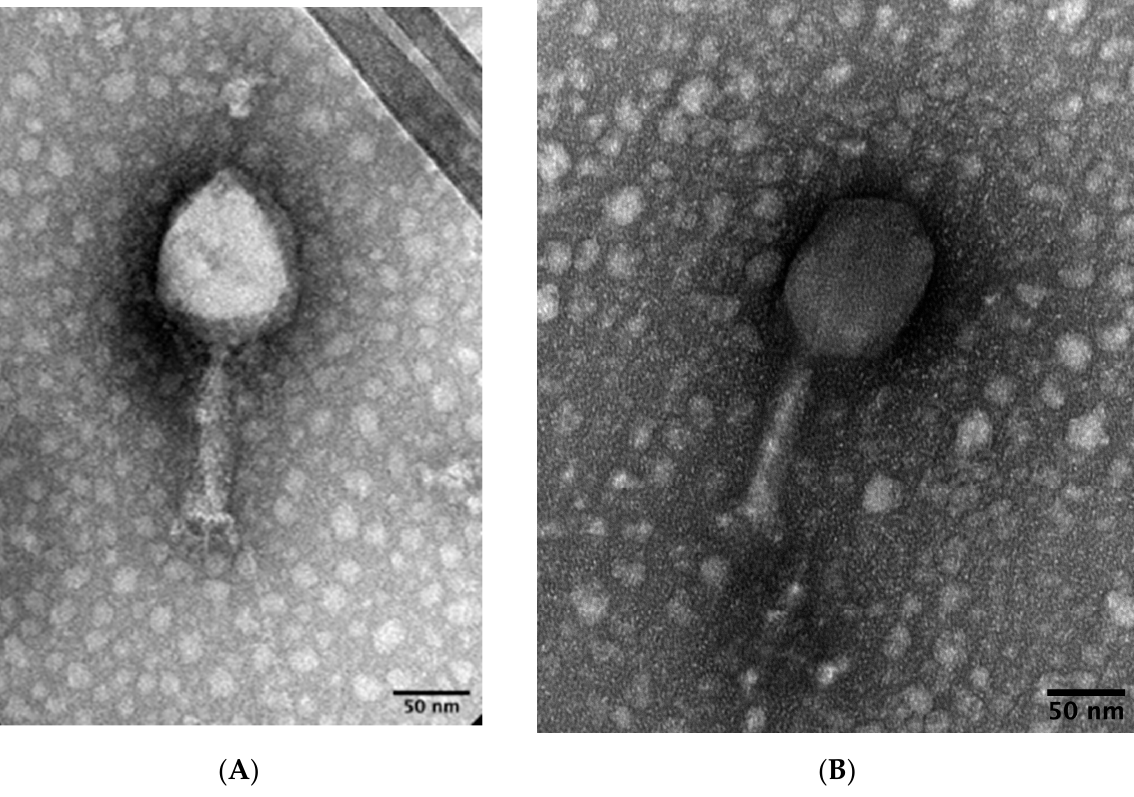
Figure 1. Transmission electron micrographs of two myoviruses. High titer stocks of liquid propa- gated DLP1 ( A ) and DLP2 ( B ) lysates were stained with 2% PTA or 1% uranyl acetate, respectively, on a copper grid at 120 or 80 kV, respectively. Prolate capsids, contractile tails, tail fibers, and base plates indicate that DLP1 and DLP2 are myoviruses.